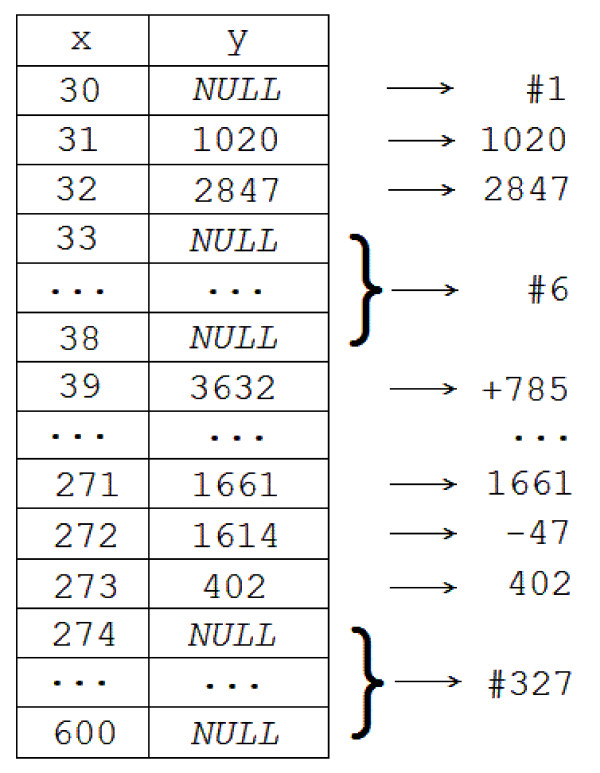


Compact spectrum representation. An example of compacting a mass spectrum.